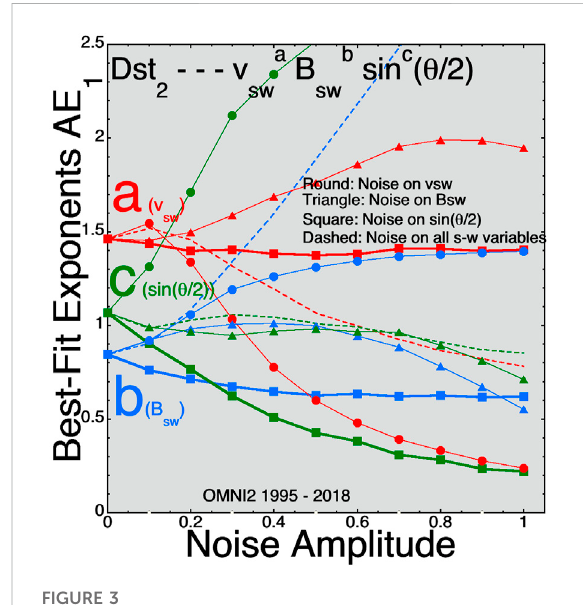
FIGURE 3 For best fi ts to the 2-hr-lagged Dst 2 index the three exponents (A) (red), (B) (blue), and (C) (green) are plotted as functions of the amplitude of the Gaussian noise added to the three solar-wind variables.